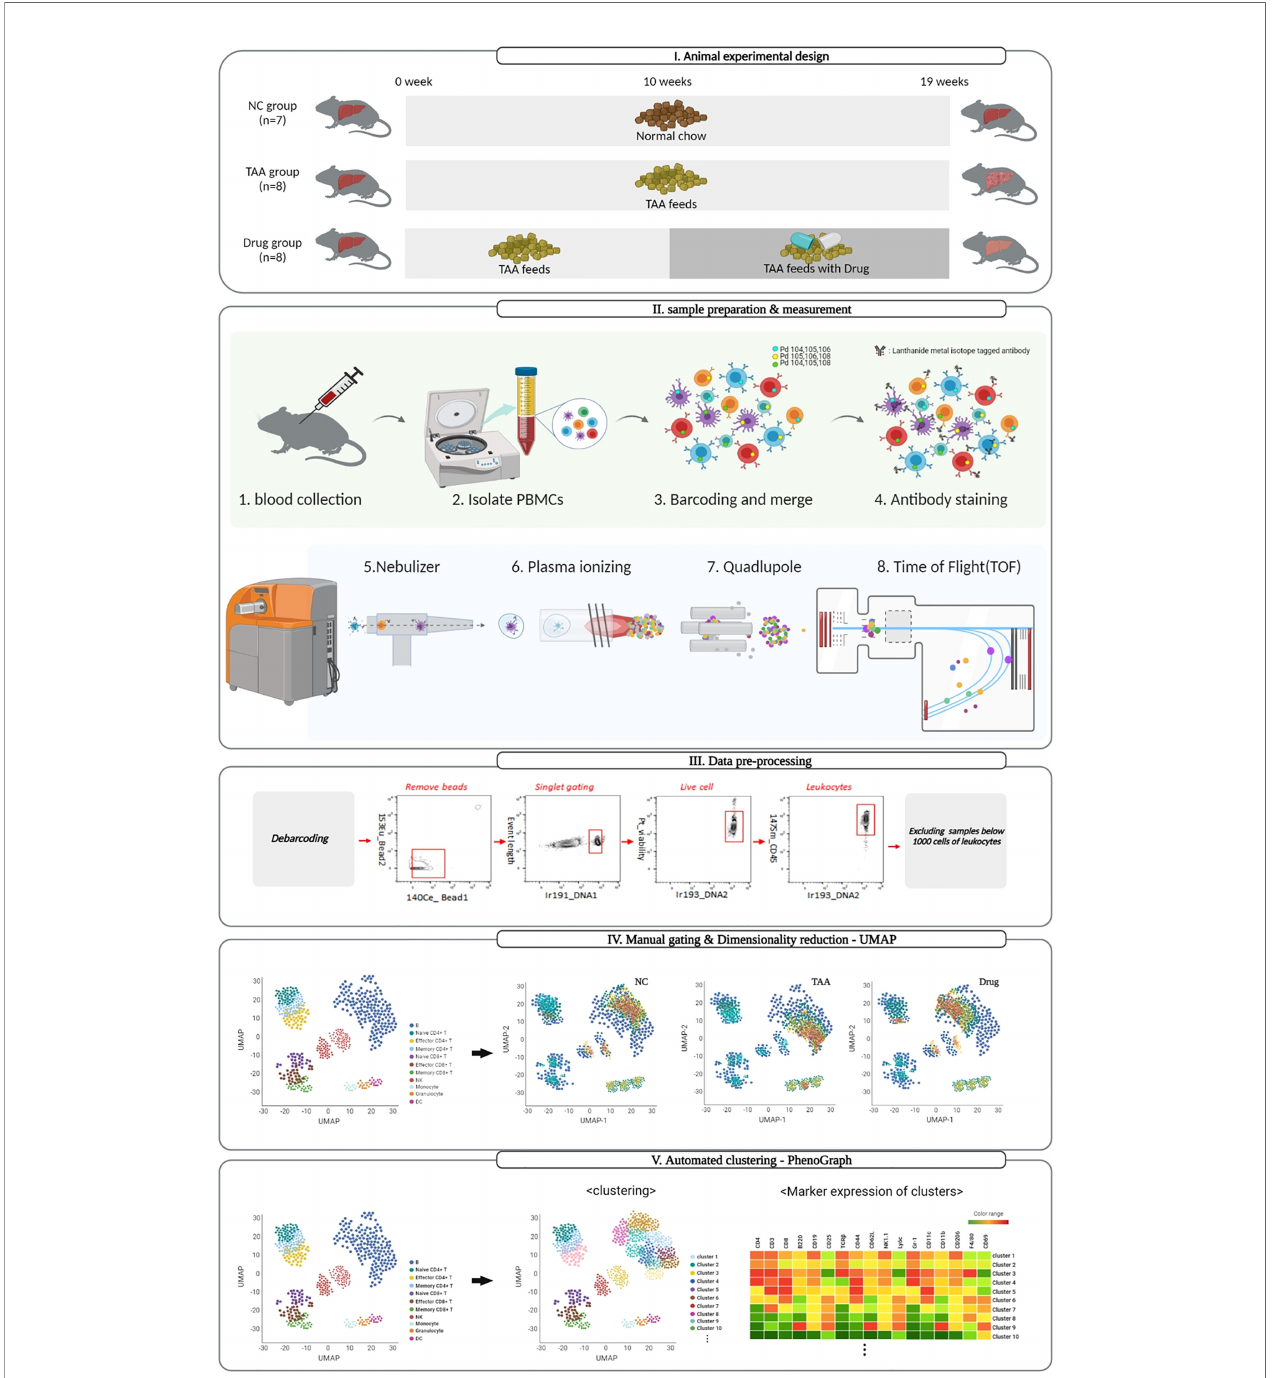
FIGURE 1 | Schematic representation of the mass cytometry work fl ow and dimensionality visualization performed by UMAP, PhenoGraph, and FlowSOM clustering to visualize data in single-cell resolution in mouse PBMC